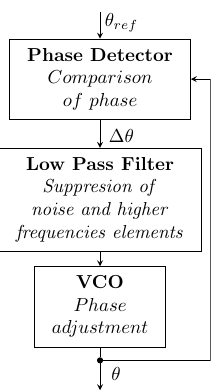
Figure 19. Function diagram of Phase-Locked Loop algorithm.